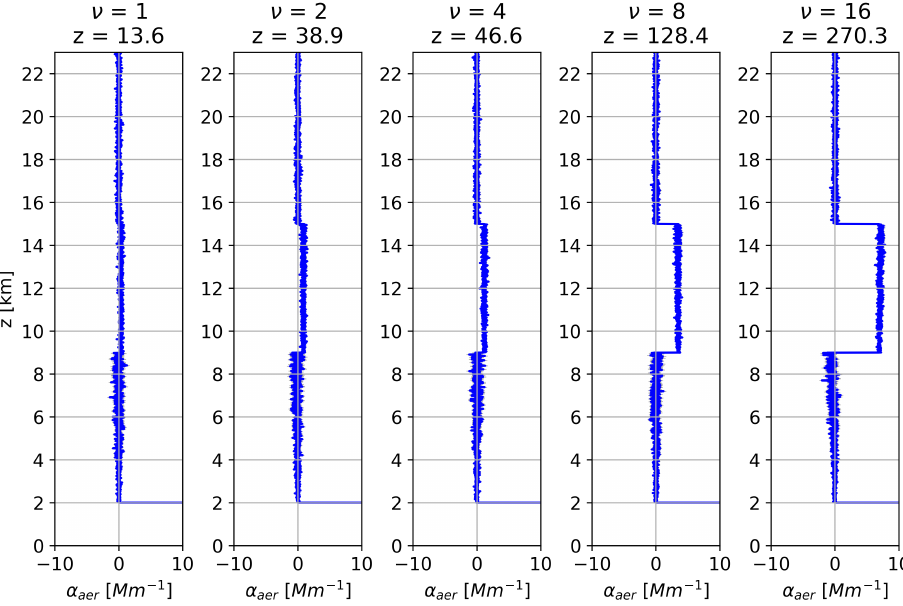
Figure 4. As Figure 3, but for ν varying from 1 to 16, and κ = 10,000. The x-scale is truncated at 10Mm − 1 to emphasize the